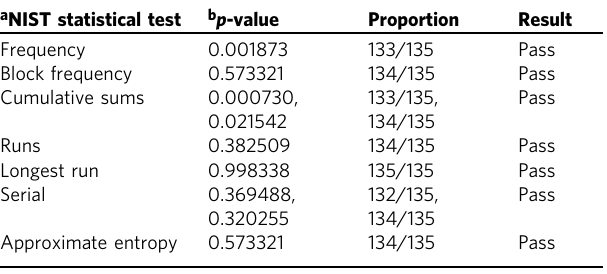
Table 1 Summary of the randomness tests of binary sequences generated from the LOP-PUF using